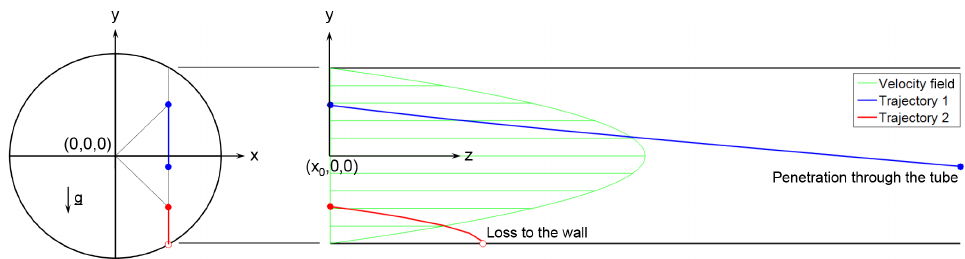
Figure F1. Particle trajectories in a vertical plane in a laminar flow tube. Particles are of the same size and are subject to gravitational settling and fluid advection. The Cartesian coordinate framework is indicated. Two different cases are shown: blue particles are those that can successfully penetrate through the tube, while red particles eventually deposit on the tube wall.